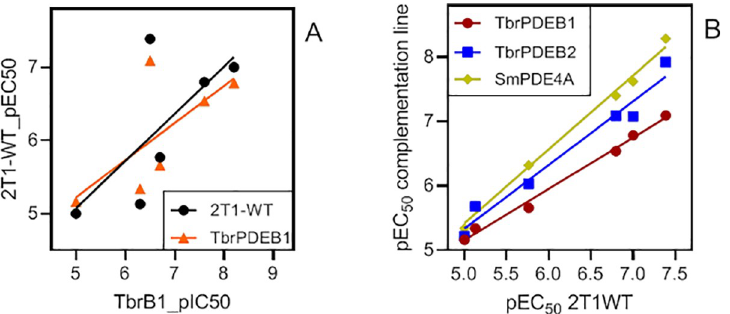
Fig 5. Analysis of the pharmacology of complementation cell lines. A . Correlation between the pIC 50 of inhibition of the purified enzyme TbrPDEB1 and pEC 50 s of the same compounds against either the parental (wild-type) cell line 2T1 (r 2 = 0.50) or the double knockout strain complemented by TbrPDEB1 (r 2 = 0.48). Both lines were found not to be significantly non-linear by F-test (Prism 8.4, P > 0.999). B . Correlation between the pEC 50 values against 2T1 cells and against the TbrPDEB1/B2 double knockout strain complemented by TbrPDEB1 (r 2 = 0.993, slope 0.797, P < 0.0001), TbrPDEB2 (r 2 = 0.967, slope 0.990, P < 0.001) or SmPDE4A (r 2 = 0.993, slope 1.148, P < 0.0001).